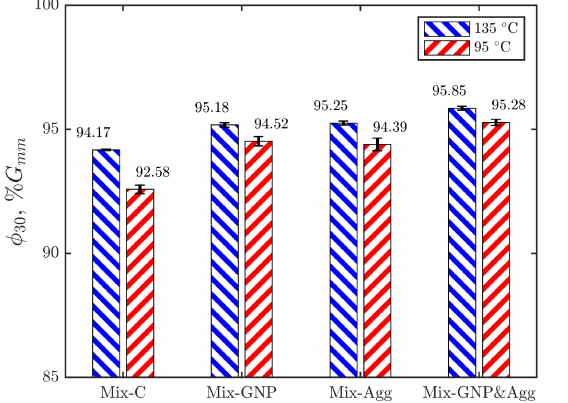
Figure 7. Bar chart of φ 30 at the two compaction temperatures.